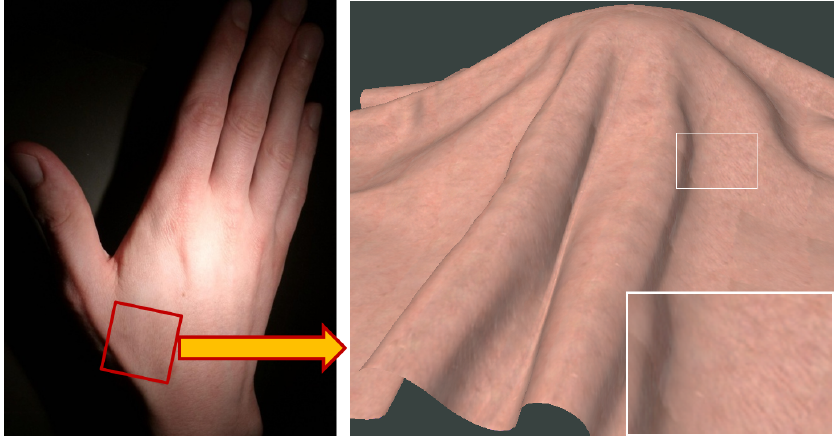
Figure 12. Measured BTF of human